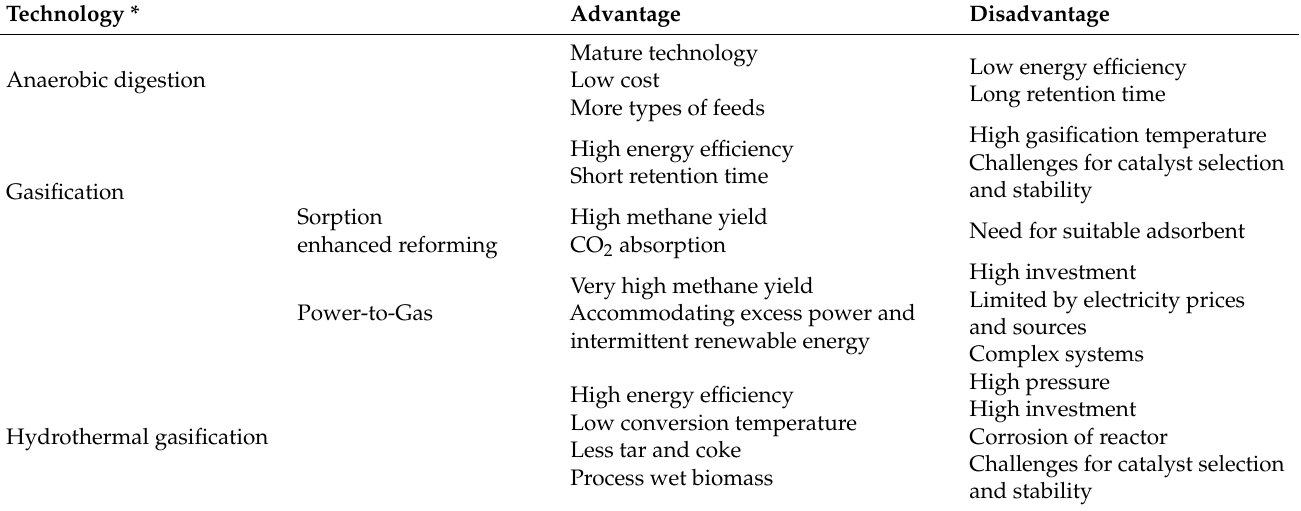
Table 1. Advantages and disadvantages of biomass-to-methane technology